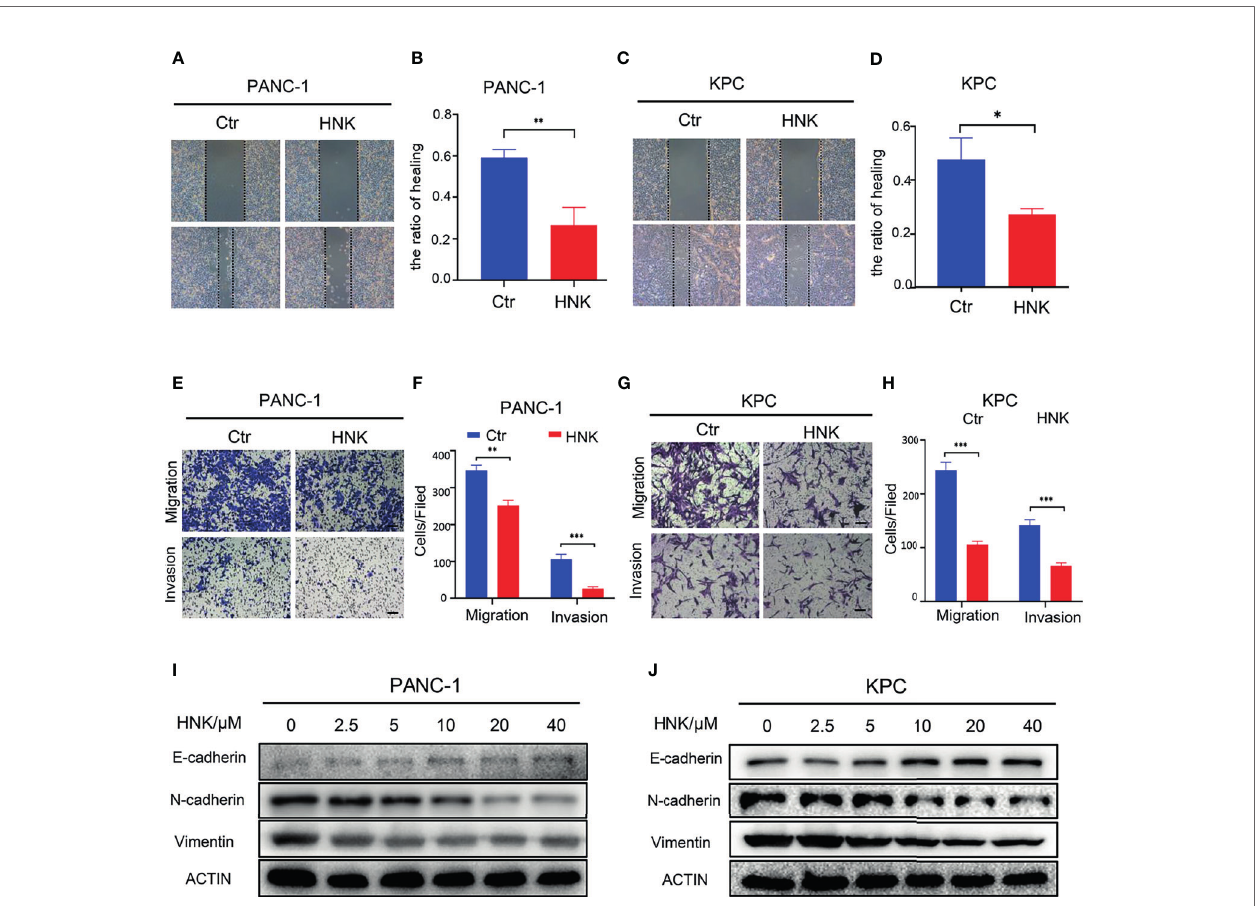
FIGURE 1 | HNK inhibits pancreatic cancer malignant behaviors and EMT. (A, B) Wound healing assays of the control group and HNK group in PANC-1 cells, scale bar = 200 m m; (C, D) Wound healing assays of the control group and HNK group in KPC, scale bar = 200 m m; (E, F) Migration assay and invasion assay of the control group and HNK group in PANC-1 cells, scale bar = 100 m m; (G, H) Migration assay and invasion assay of the control group and HNK group in KPC, scale bar = 100 m m; (I, J) Western blotting analysis of the expression of EMT-associated proteins (N-cadherin, E-cadherin, and Vimentin) in PANC-1 and KPC cells. * p < 0.05, ** p < 0.01, *** p <